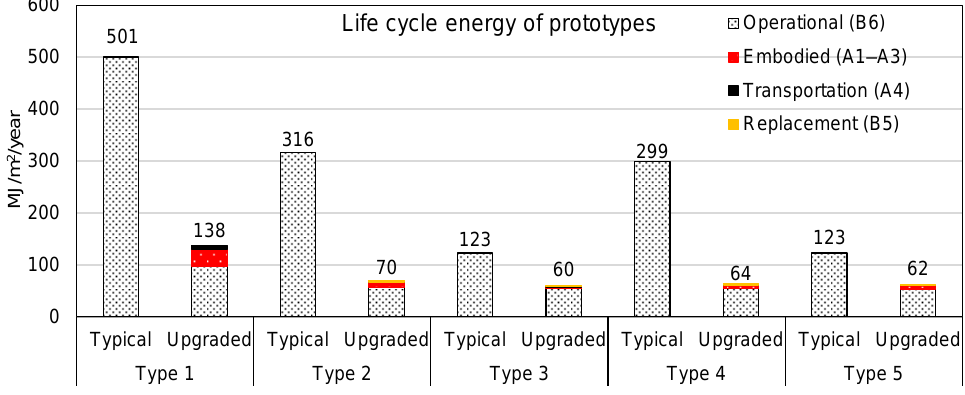
Figure 3. Comparison of lifecycle energy impacts of prototype buildings .